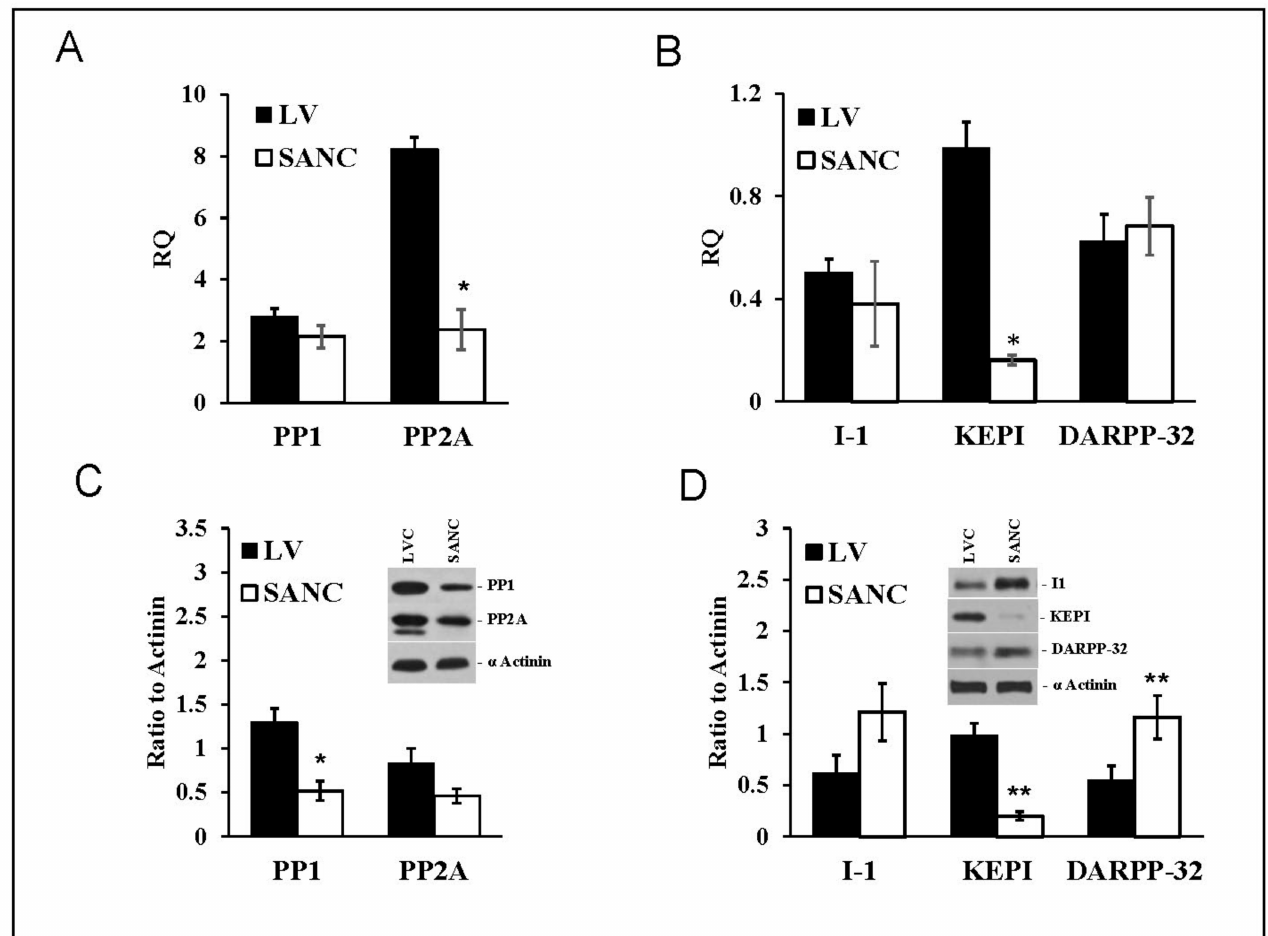
Figure 2. mRNA expression ( A , B ) and protein abundance ( C , D ) (Mean+/ − SEM) patterns of PP1, PP2A, and PP1 en- dogenous inhibitors (I-1, KEPI and DARPP-32) normalized to β -tubulin (mRNA) or α -actinin in LVC and SANC ( n = 6 independent hearts analyzed per group); * p < 0.05, ** p < 0.01 compared to LVC. For alternative transcript names see Table S1. For Primers and probes used for RT-QPCR see Table